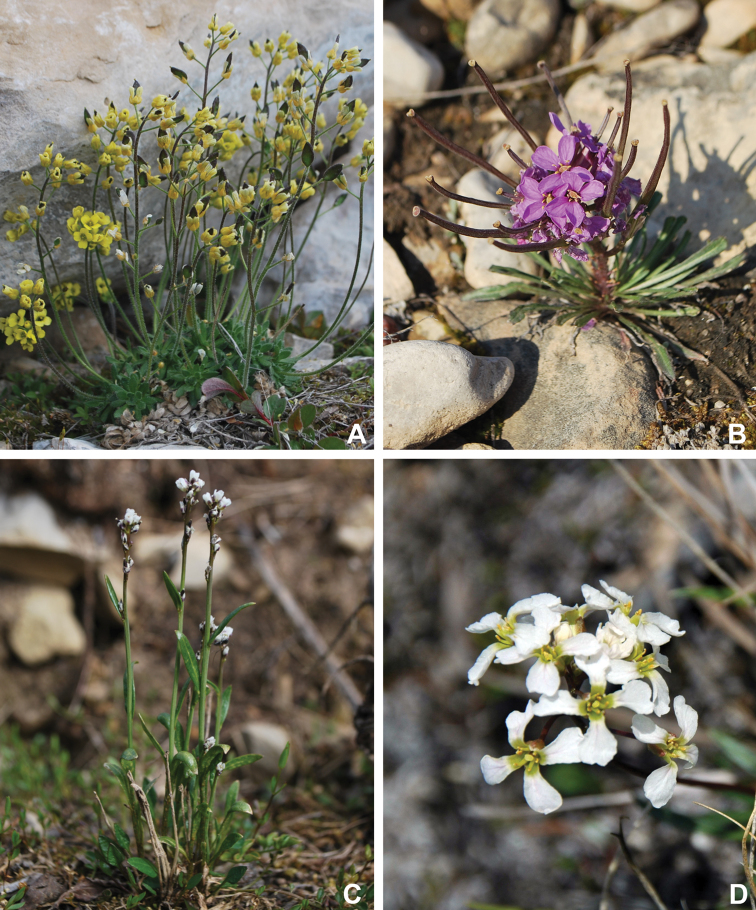
ADraba
simmonsii, habit BErysimum
pallasii, habit CEutrema
edwardsii habit DParrya
arctica inflorescence, Gillespie et al. 7488. Photos A–C by B.A. Bennett and D by R.D. Bull.